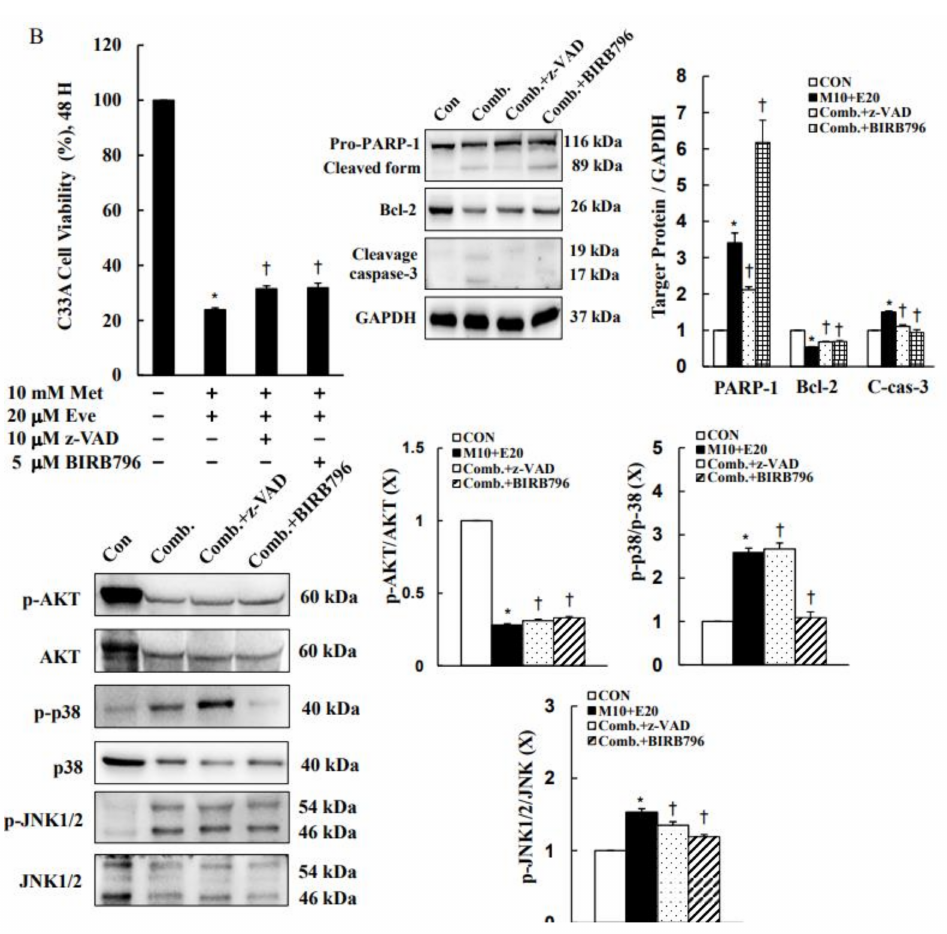
Figure 7. z-VAD-fmk and BIRB796 altered metformin- and everolimus-induced apoptosis-related protein expressions. CaSki and C33A cells were pretreated with or without z-VAD-fmk (10 µ M) and BIRB796 (5 µ M) for 2 h, then treated with or without metformin (10 mM) and everolimus (20 µ M) for 48 h. ( A ) CaSki and ( B ) C33A cell viability was determined using a CCK-8 assay. Protein expression levels of PARP-1, Bcl-2, cleaved caspase-3, p-AKT, AKT, p-p38, p38, p-JNK1/2, and JNK1/2 were assessed using Western blotting. GAPDH served as the loading control. Quantitative results are presented in the bottom plot. Values represent the mean ± SD from three replicates. * and † p < 0.05 compared with the CON and Met + Eve-treated groups. CON, 0.1% DMSO; Comb, M10 + E20, 10 µ M metformin + 20 µ M everolimus; Comb + z-VAD, 10 µ M metformin + 20 µ M everolimus + 2.5 µ M z-VAD-fmk; Comb + BIRB798, 10 µ M metformin + 20 µ M everolimus + 5 µ M